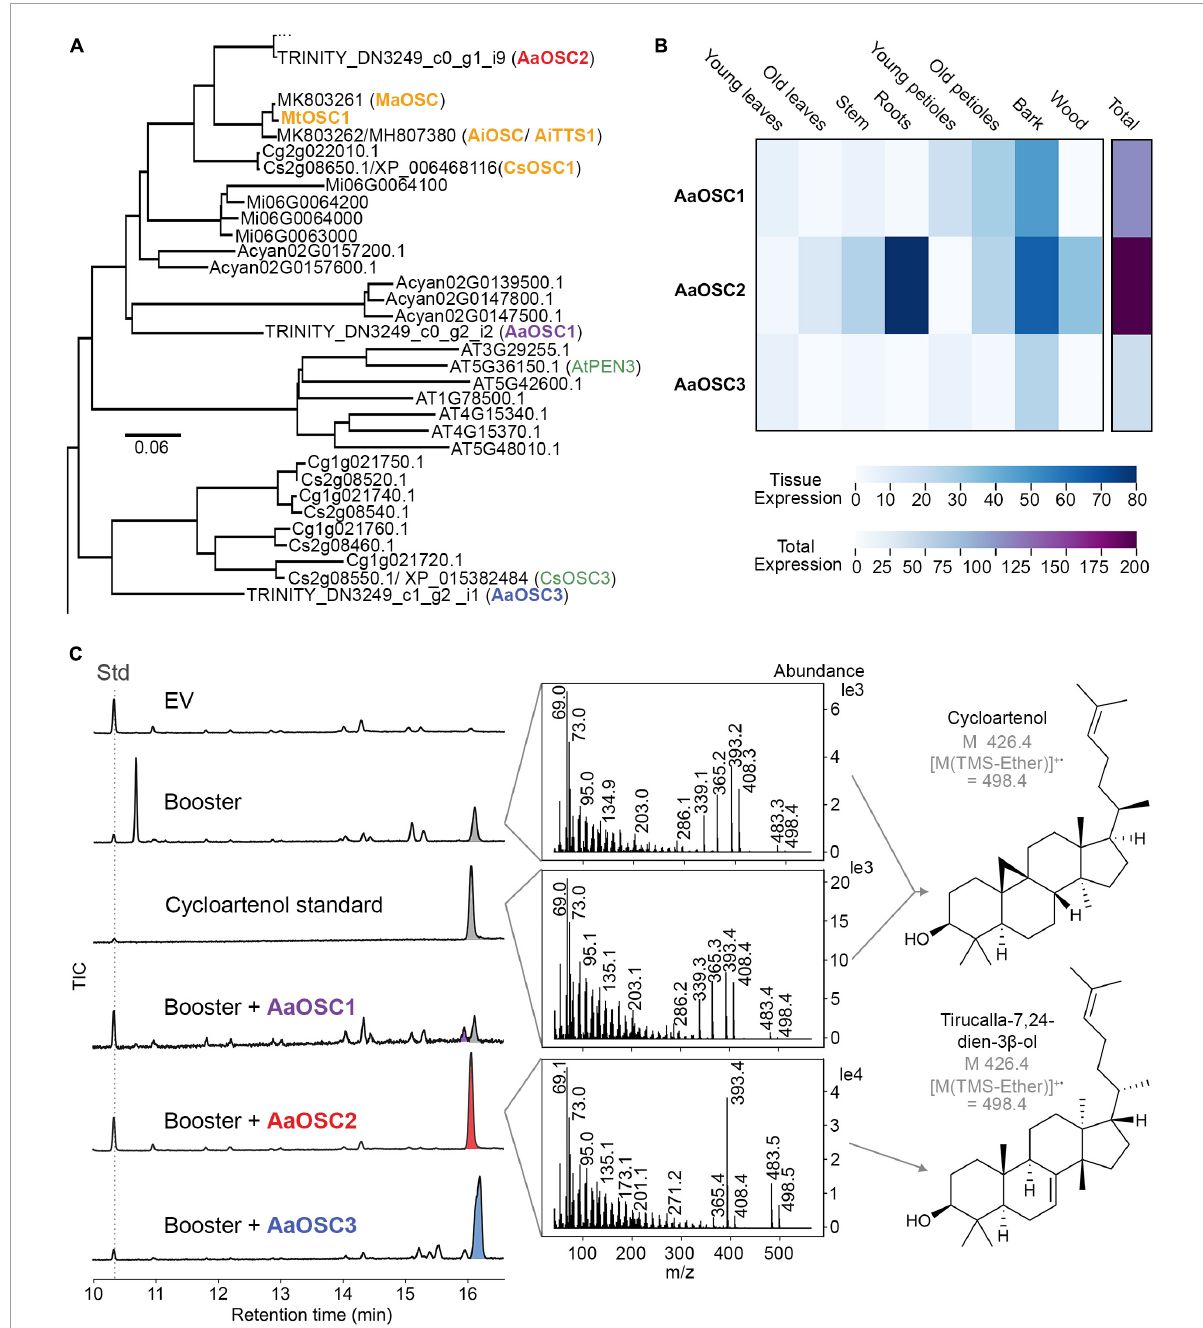
FIGURE3 The oxidosqualene cyclase (OSC) AaOSC2 from Ailanthus altissima is a tirucalla-7,24-dien-3 β -ol synthase. (A) Partial phylogenetic tree of OSCs; the full tree is shown in Supplementary Figure 1 . OSC amino acid sequences were extracted from five Sapindales species, including the tree of heaven ( Ailanthus altissima ), orange ( Citrus sinensis ), pomelo ( Citrus grandis ), mango ( Mangifera indica ), and yangbi maple ( Acer yangbiense ), and two species outside of Sapindales, including Arabidopsis thaliana and Nicotiana benthamiana , were aligned using Clustal Omega, and a phylogenetic tree reconstructed using the neighbour-joining method. The scale bar indicates the phylogenetic distance. (B) Expression levels of each contig (trimmed mean of M -values (TMM)) are visualised as a heat map. Young leaf, old leaf, stem and root tissues are from 8-week-old seedlings. Young petioles, old petioles, bark and wood are from 3-year-old trees. (C) GCMS total ion chromatograms of each candidate AaOSC co-expressed with booster genes in Nicotiana benthamiana . EV is empty vector control. Booster genes include AatHMGR , AaFPS , AaIPPI, and AaSQS . 5 α -cholestane was used as an internal standard (Std). Mass spectra of co-eluting peaks of cycloartenol and tirucalla-7,24-dien-3 β -ol at 16.0 min (grey and red, respectively) are shown. Chromatograms and mass spectra for AaOSC1 and AaOSC3 products (purple and blue, respectively) are shown in Supplementary Figures 3 , 4